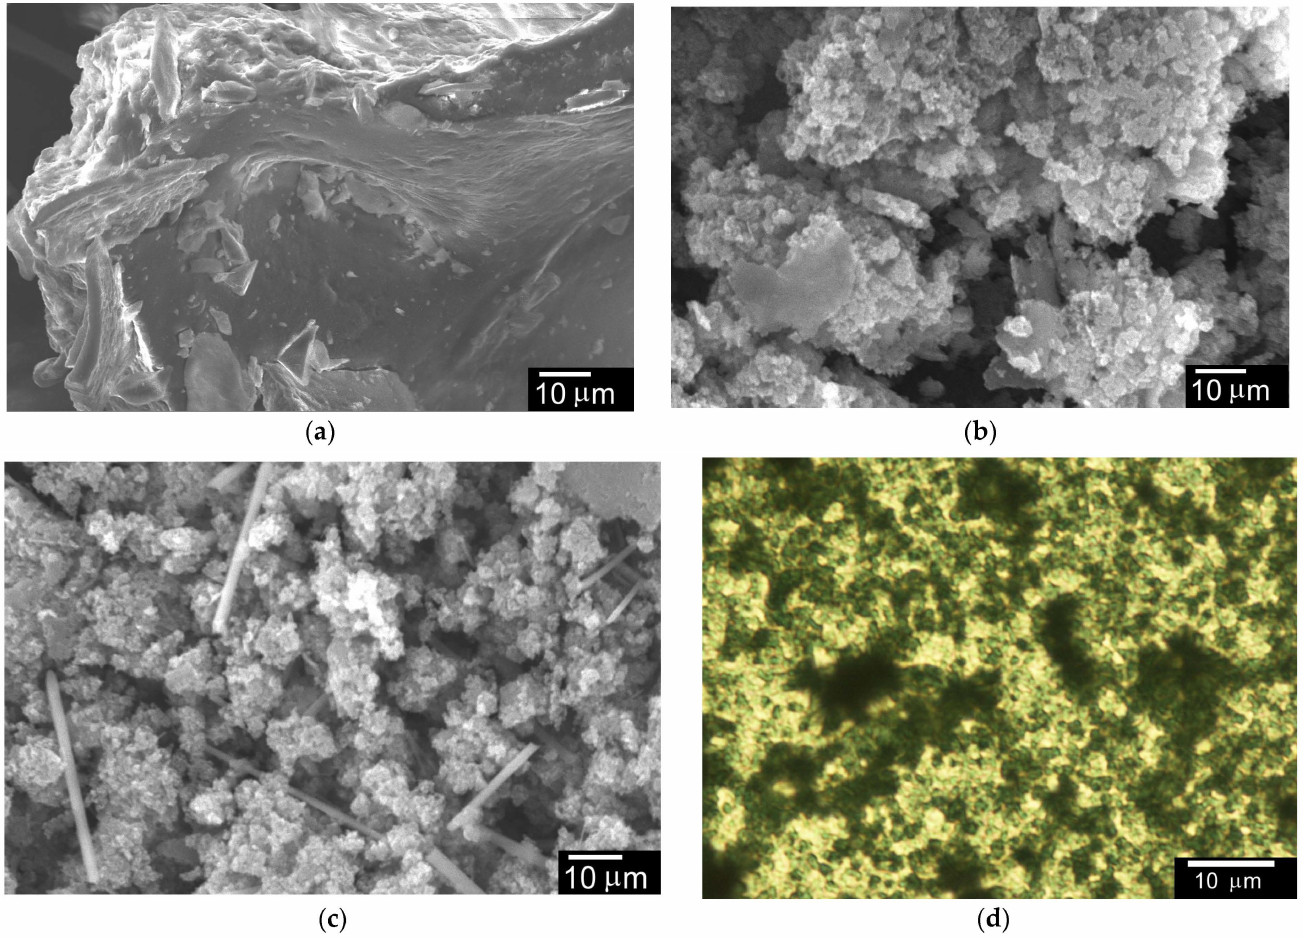
Figure 18. Scanning electron microscopy (SEM) and optical microscopy images of fucoidan and polymer composites. ( a ) fucoidan, ( b , c ) fucoidan/C-PANI(gel), and ( d ) optical microscopy image of